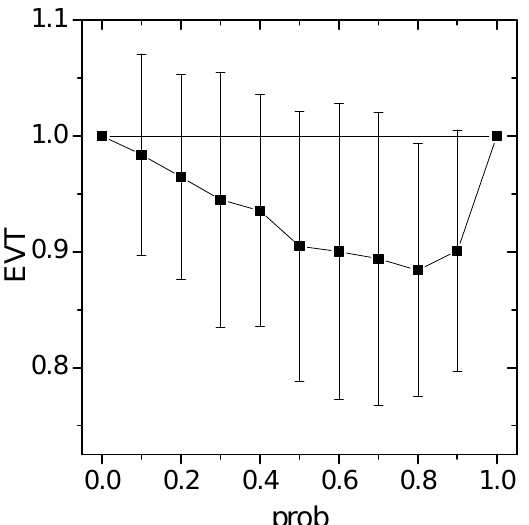
Figure 7. Dependence of the left part of Equation (6) for percolated hybrid composites of different